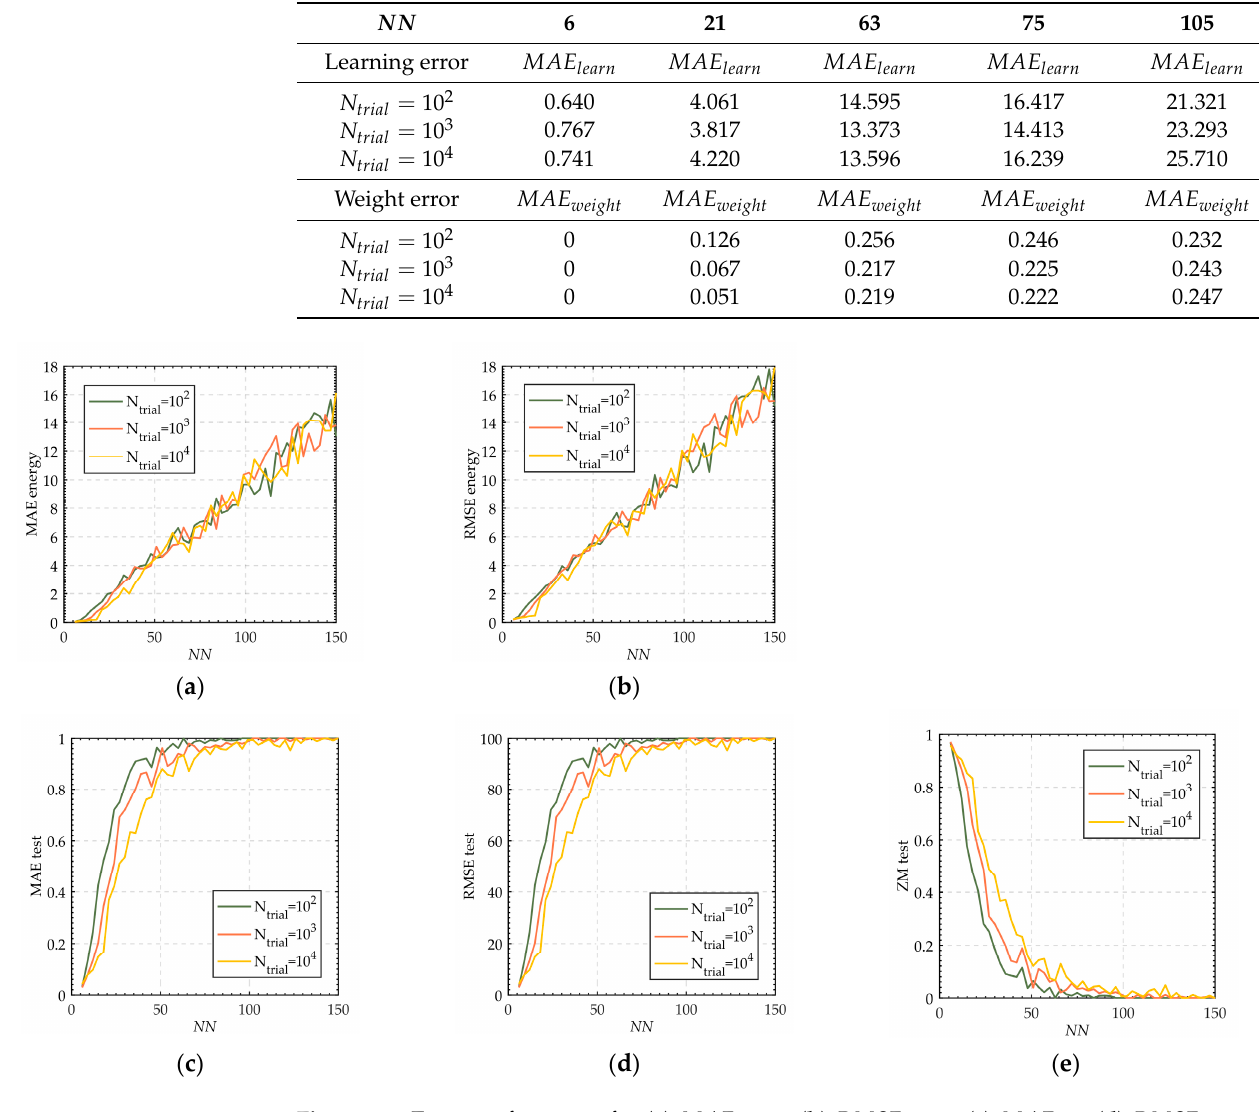
Table 14. The values of MAE learn and MAE weight for GRAN3SAT.